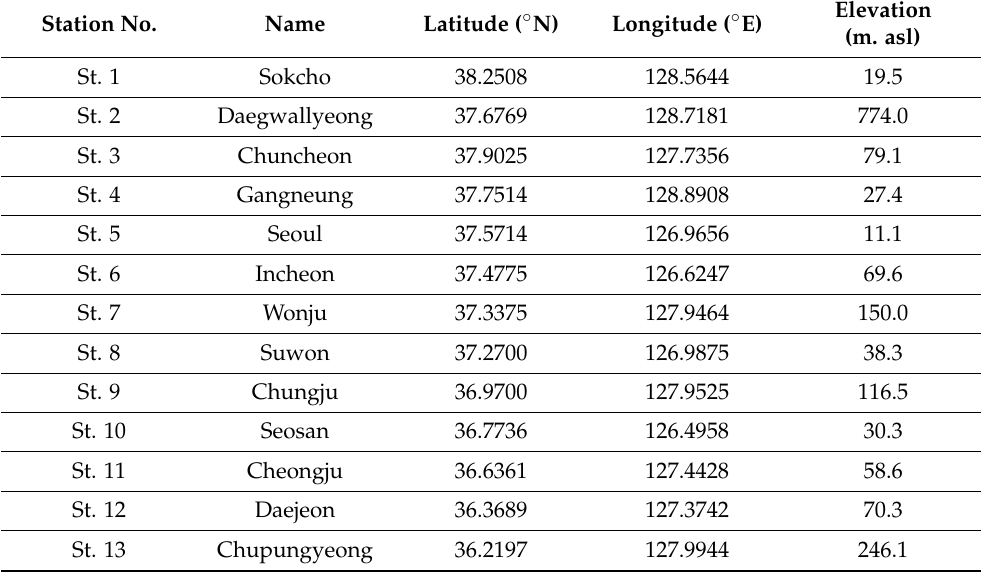
Table 1. Station information employed in the study.